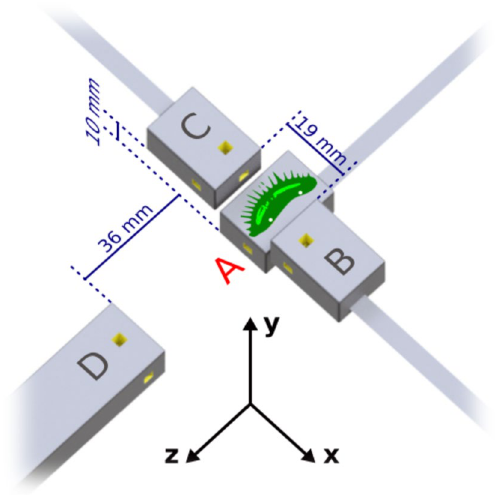
Figure 3. Schematic of the experimental setup in the magnetically shielded room. The plant sample, an isolated lobe of the flytrap, is placed on top of primary sensor A, in the x – z plane with trigger hairs exposed. For reference, the dimensions of the housing (gray boxes) for the primary and secondary sensors are 24.4 × 16.6 × 12.4 mm 3 . Yellow cut-outs indicate the position of the 3 × 3 × 3 mm 3 atomic sensing volume. A 3D-printed ABS plastic structure (not shown) holds the magnetometers in position on a wooden table. White dots on the plant sample, approximately 1 cm apart, indicate the placement of surface electrodes for AP monitoring. In the coordinate system shown, all magnetometers are sensitive along the y -axis, normal to the surface of the plant sample; furthermore, A and D are sensitive along the z -axis, and B and C are sensitive along the x -axis. Sensors B and C are positioned symmetrically around sensor A. Sensor D serves as a background sensor and is therefore located farther away from the sample.